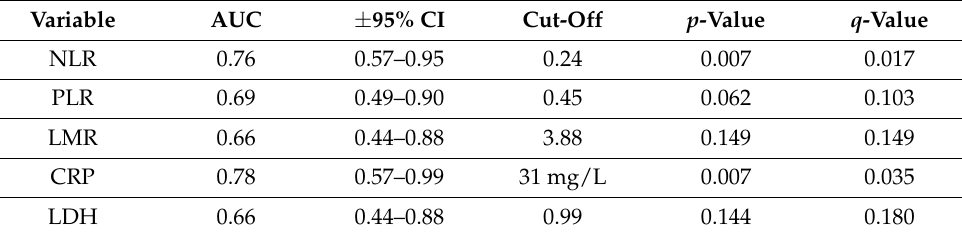
Figure 6. Receiver operating curves plotted for age-adjusted NLR, PLR, LMR, and LDH in pe- diatric patients with MPNST to predict events. Abbreviations: CRP—C-reactive protein, NLR— neutrophil-to-lymphocyte ratio, PLR—platelet-to-lymphocyte ratio, LMR—lymphocyte-to-monocyte ratio, LDH—lactate dehydrogenase. Table 4. Areas under curves and cut-off values (established with Youden index) for investigated